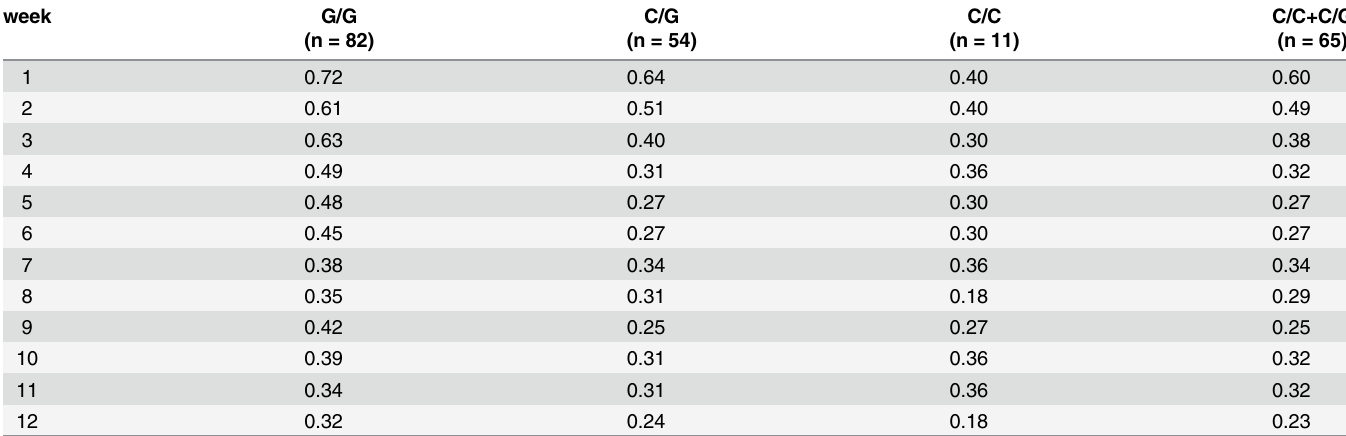
Table 3. Average weekly FLS prevalence in patients divided based on the IL-6 genotypes or on the presence of the C